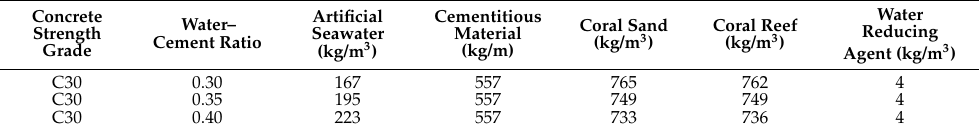
Table 5. Coral aggregate seawater concrete mix